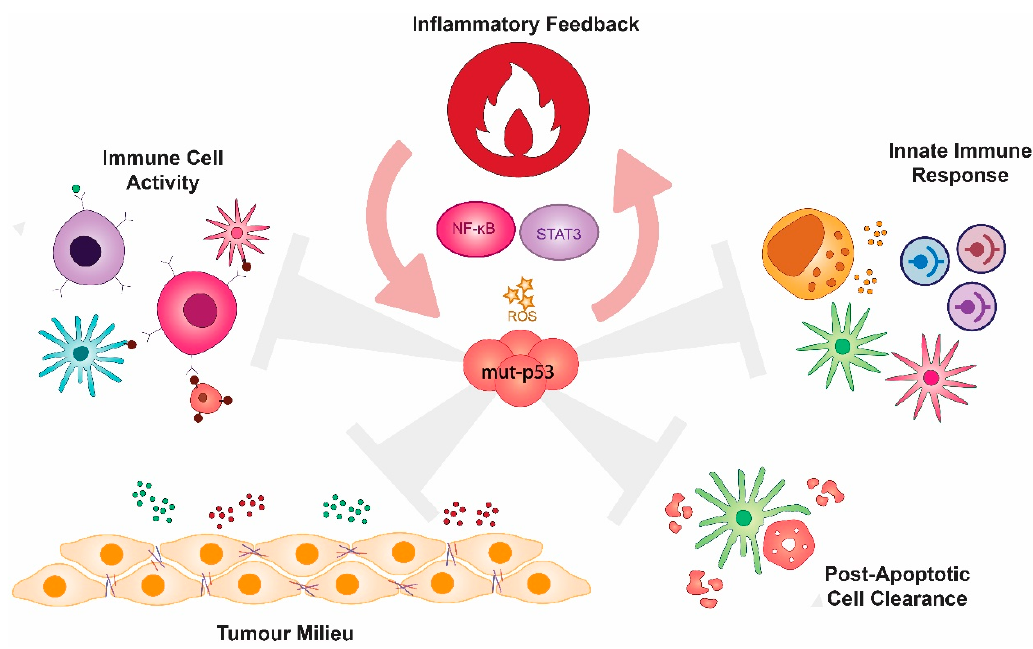
Figure 3. Mutant p53 impacts on the immune and inflammatory hallmarks of cancer. Mutant p53 responds to and contributes to cancer-associated chronic inflammation which facilitates several immune gain-of-functions. These are highlighted by the mutant p53-mediated alteration of the tumour milieu (pro-invasive extracellular matrix structure, cancer-associated fibroblast activity, tumour-tolerant immune cell infiltrate and chemical signatures), disabling of the innate immune response through aberrant toll-like receptor signalling, the inhibition of cell-mediated cancer immunity and potentially disrupting post-apoptotic cell clearance.